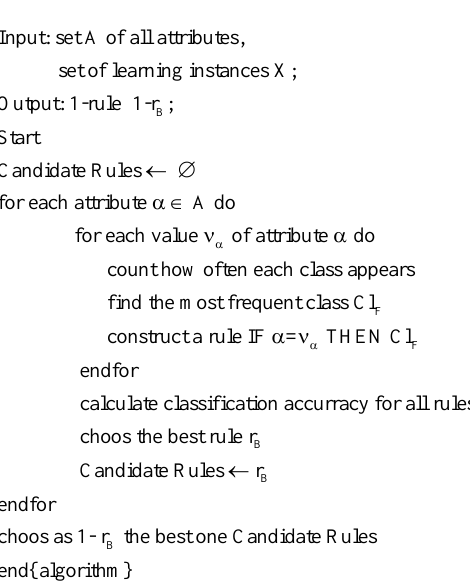
Figure 4. The pseudo code of the One-R algorithm.